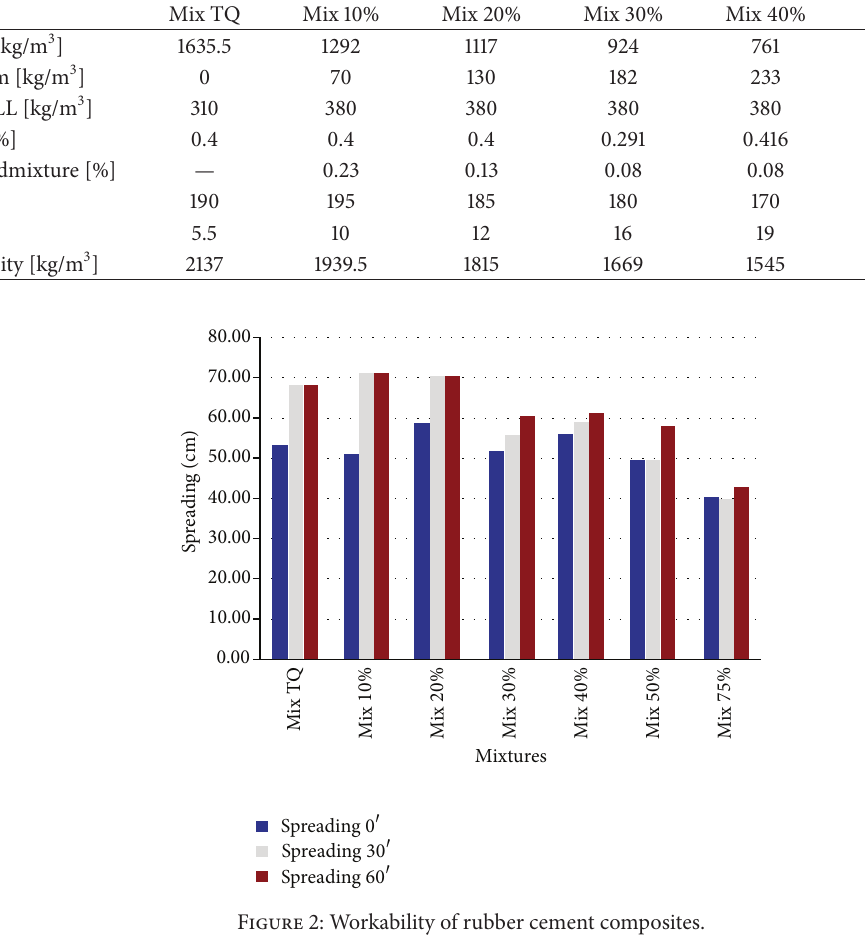
Figure 2: Workability of rubber cement composites.